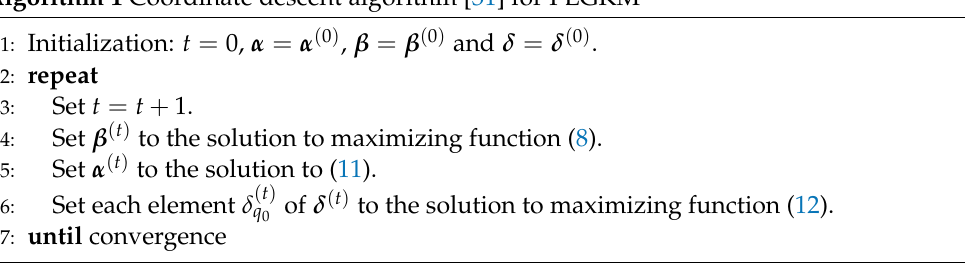
Algorithm 1 Coordinate descent algorithm [31] for